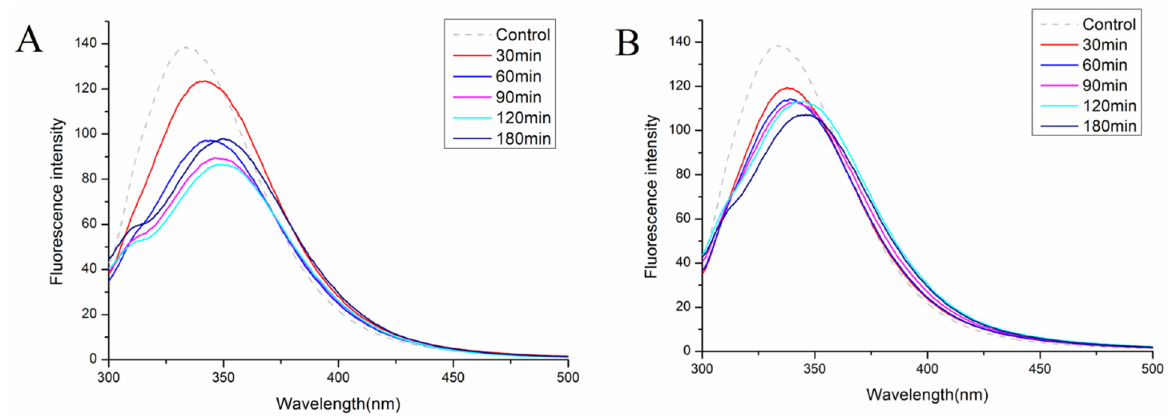
Figure 4. Structural characterization of SPI and hydrolysates. Relative fluorescence spectra of SPI and hydrolysates prepared with ACHNs ( A ) and DCHNs ( B ).